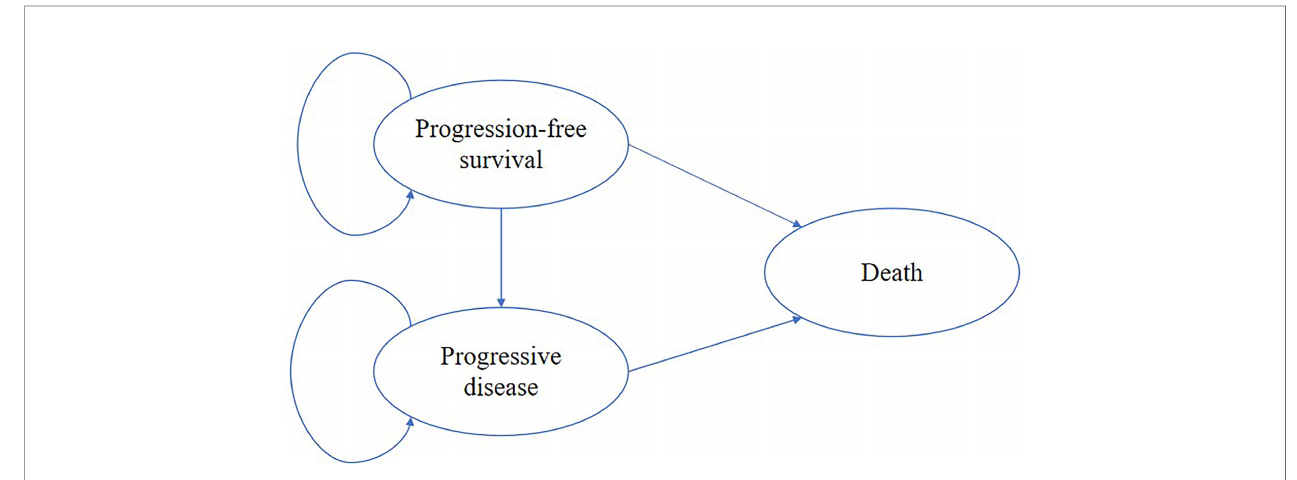
FIGURE 1 | The Markov model simulated three health states: progression-free survival, progressive disease and